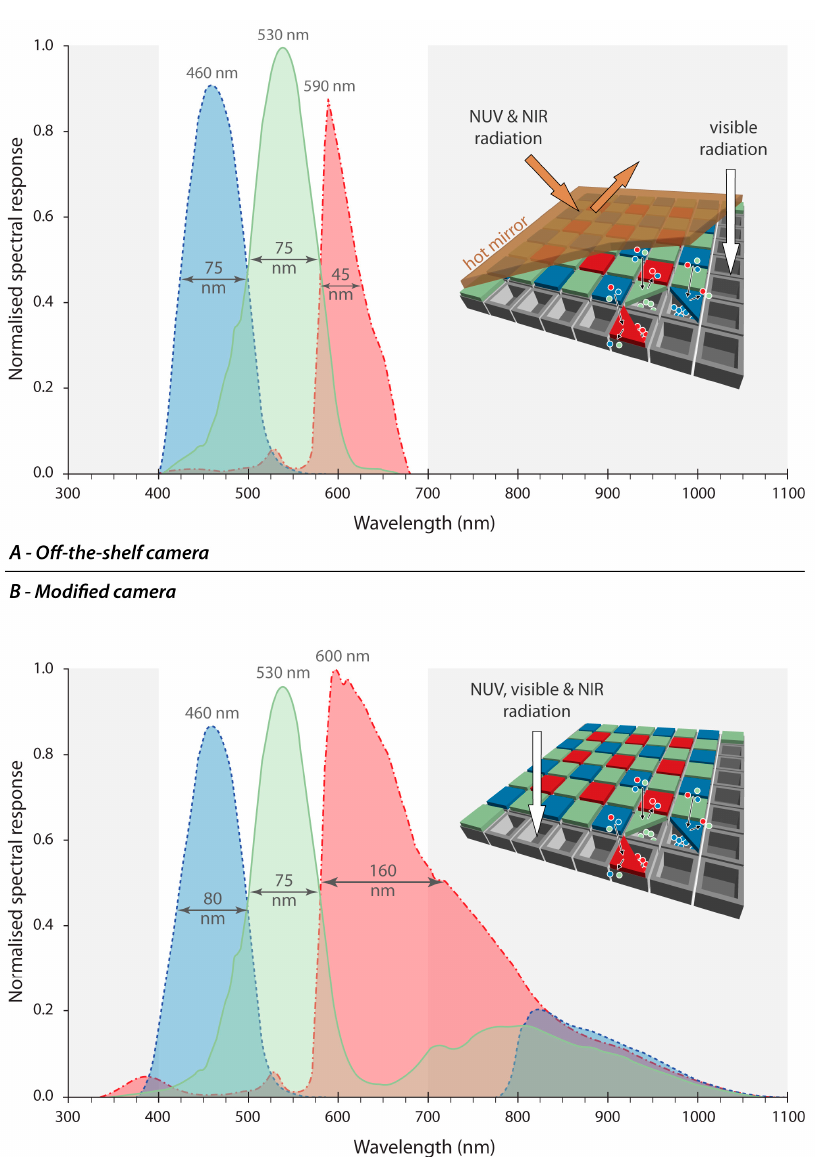
Figure 1. The spectral responses and layout of a typical DSC image sensor with Bayer CFA. ( A ) shows the relative spectral response curves from an off-the-shelf model (i.e., with its hot mirror in place); ( B ) indicates the camera’s spectral sensitivity in the invisible NUV and NIR regions (both indicated in grey) upon removing this internal blocking filter. For every channel, the wavelength of maximum transmission and the bandpass in terms of full-width at half-maximum are indicated.